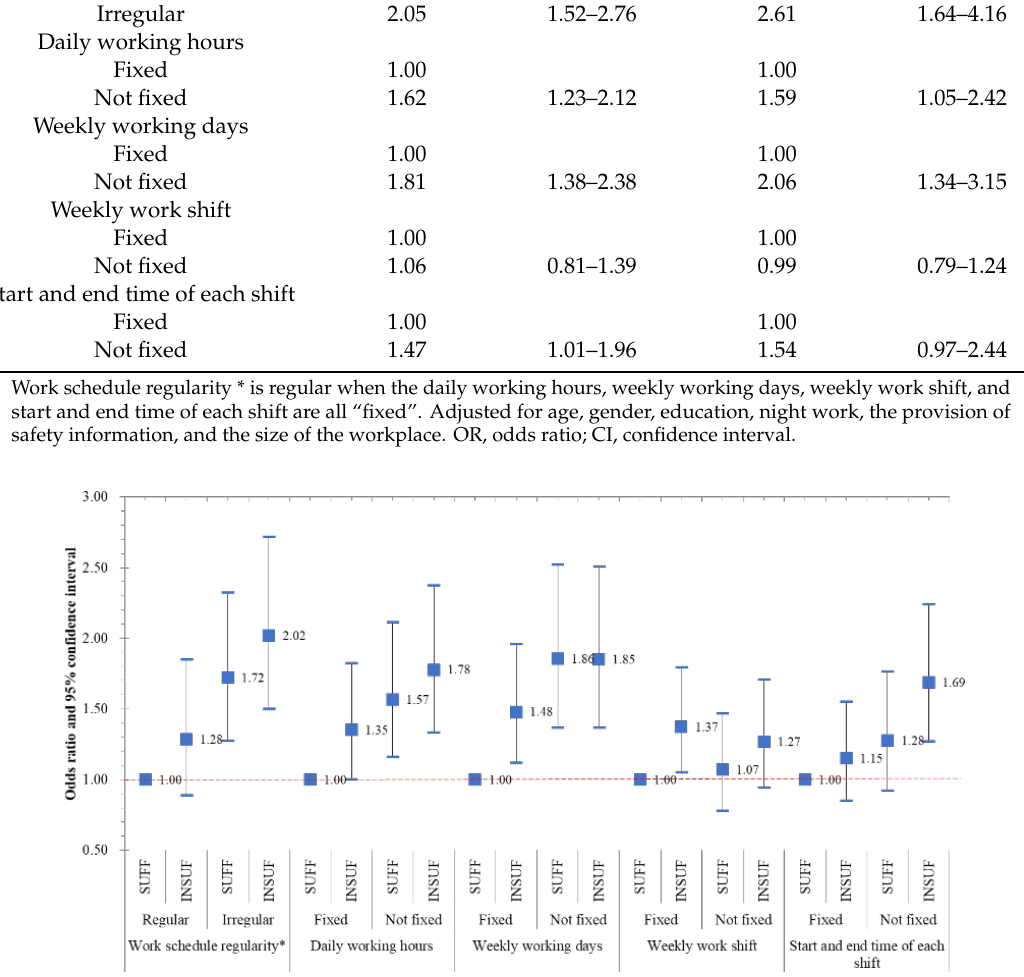
Figure 1. Odds ratio of work-related injuries according to work schedule regularity with sufficiently and insufficiently provided safety information. Work schedule regularity * is regular when the daily working hours, weekly working days, weekly work shift, and start and end time of each shift are all “fixed”. “SUFF” means that su ffi cient safety information was provided. All the models were controlled for age, gender, education level, the size of the workplace, and work